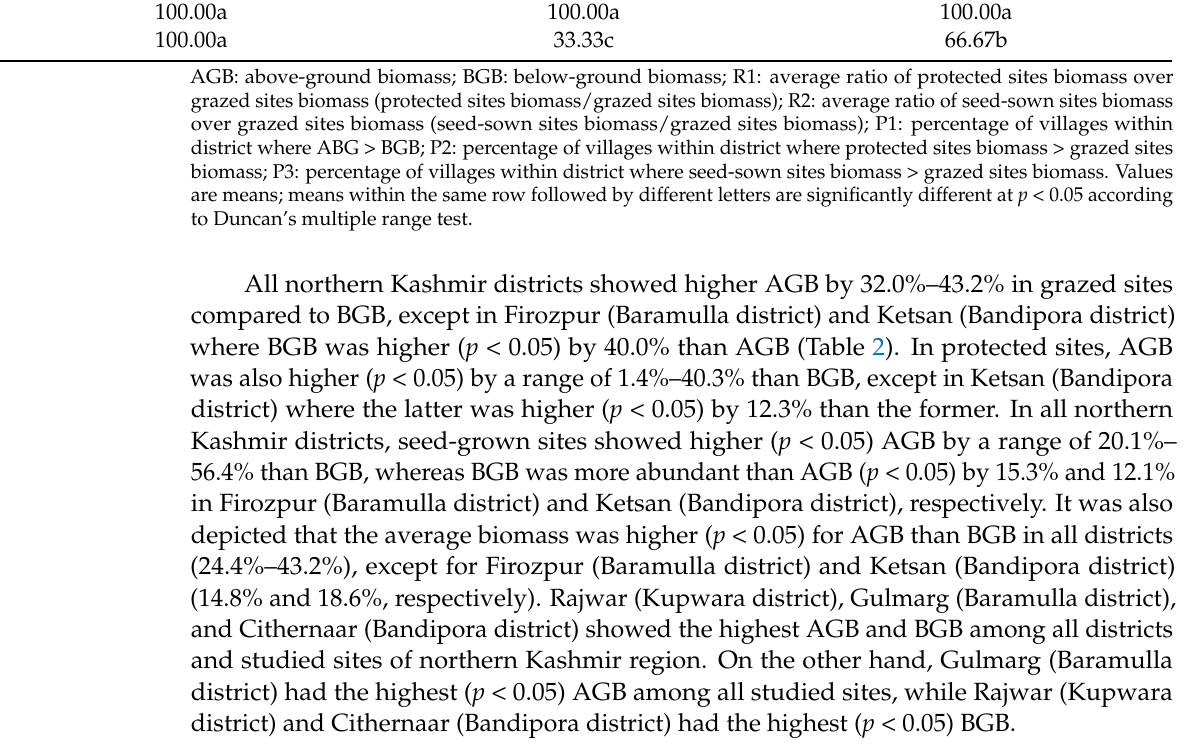
Table 2. Above (AGB) and below Ground Biomass (BGB) (t/ha) in the pasture of northern